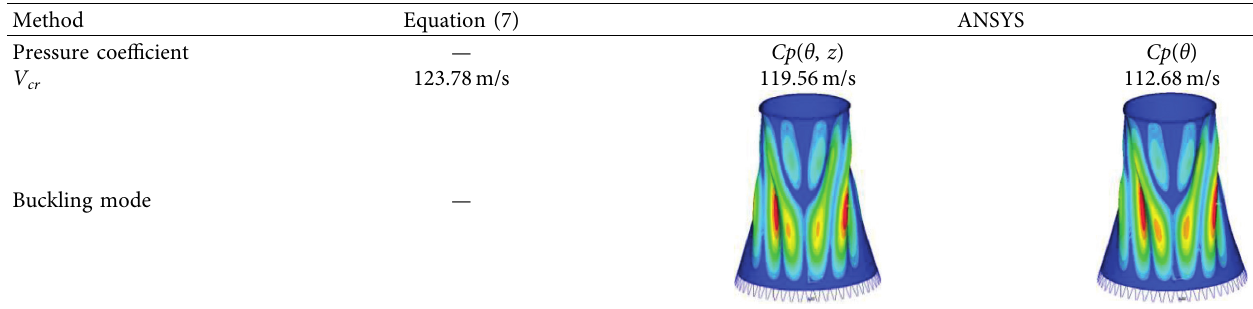
Table 2: Comparison of overall